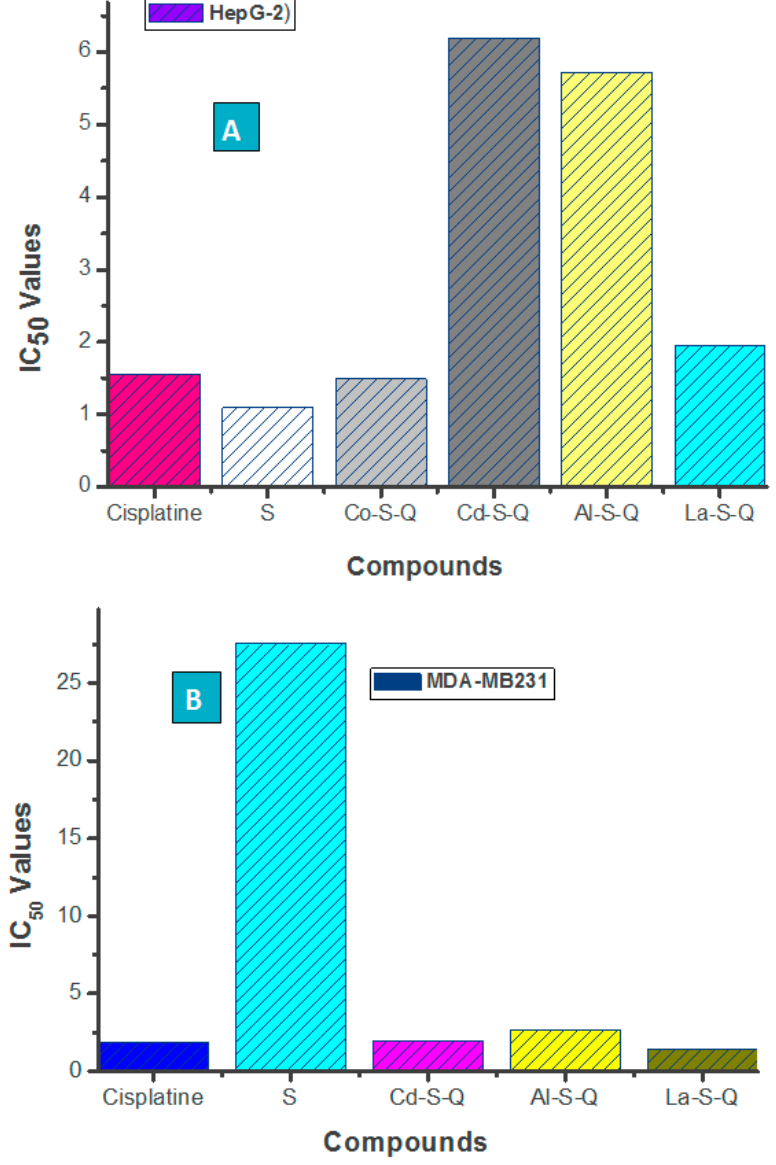
Figure 11. IC 50 Values of salen and its Cd(II), Al(III), and La(III) mixed 8-hydroxyquinoline metal complexes against ( A ) Hep-G2 carcinoma cell lines compared to cisplatin and against MDA-MB231 ( B ) breast carcinoma cell lines compared to cisplatin.